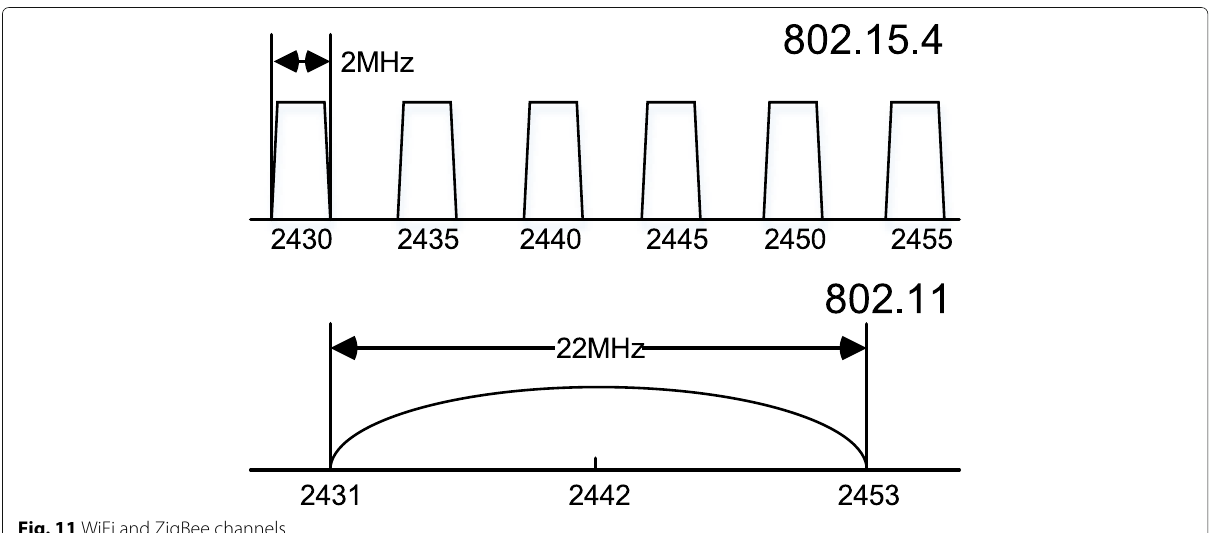
Fig. 11 WiFi and ZigBee channels